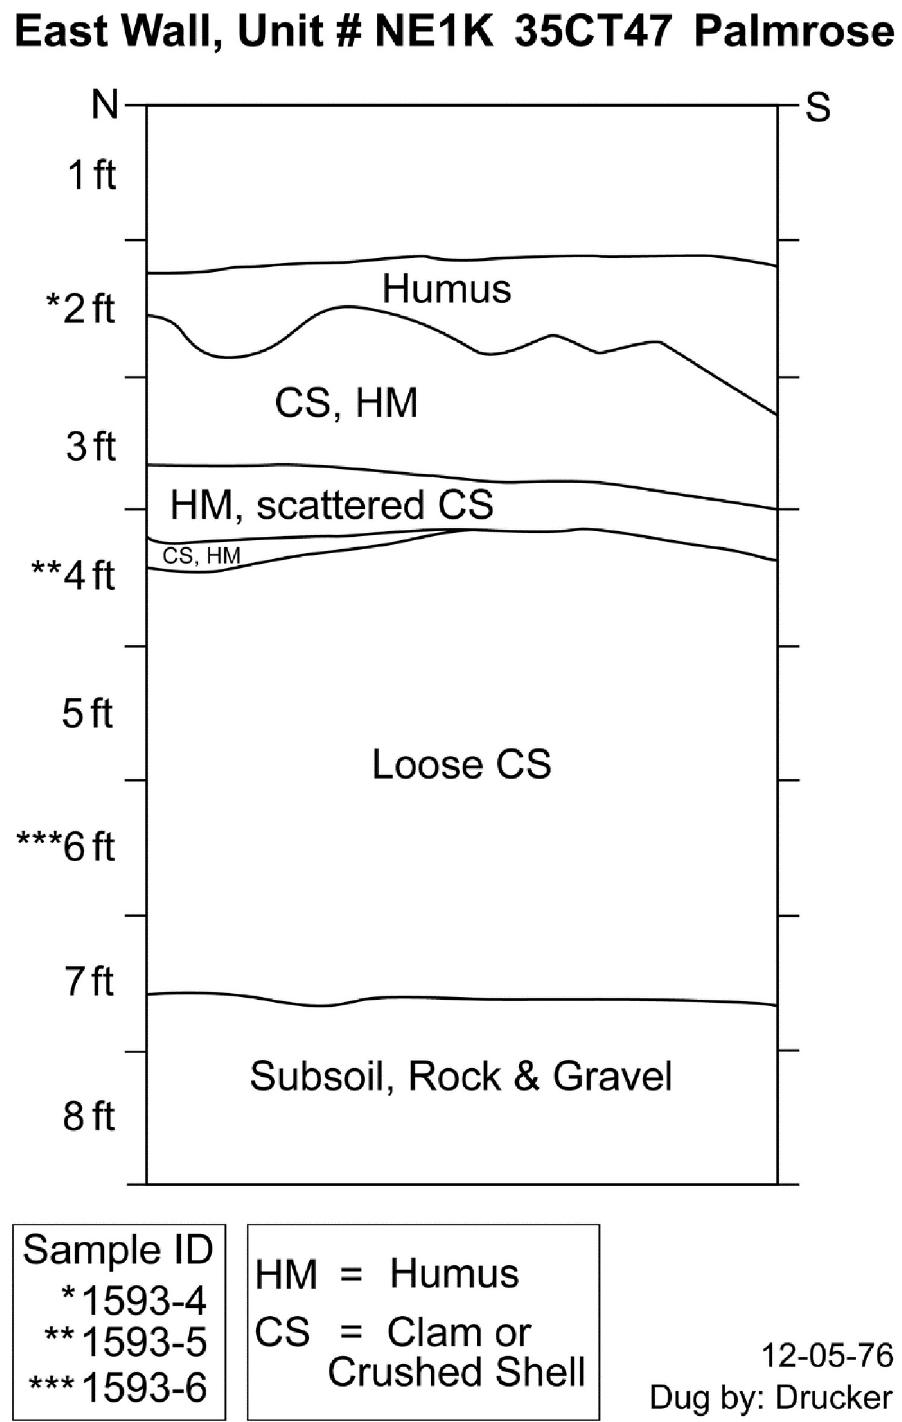
Fig 3. Palmrose unit NE1K east wall profile. Level provenience of radiocarbon samples noted. Adapted from Palmrose excavation notes.